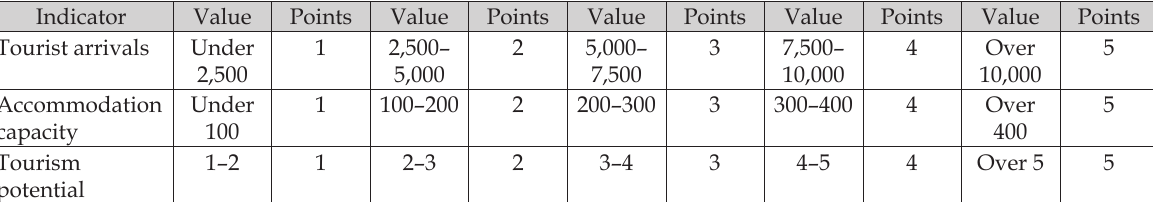
Table 5. Analysis of the tourism potential of the Danube